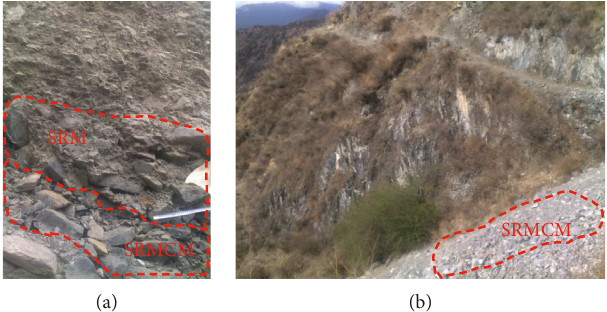
Figure 3: Formation mechanism of the SRMCM. (a) SRM overlying or underlying the SRMCM. (b) The multilayer SRMCM in Mahe talus